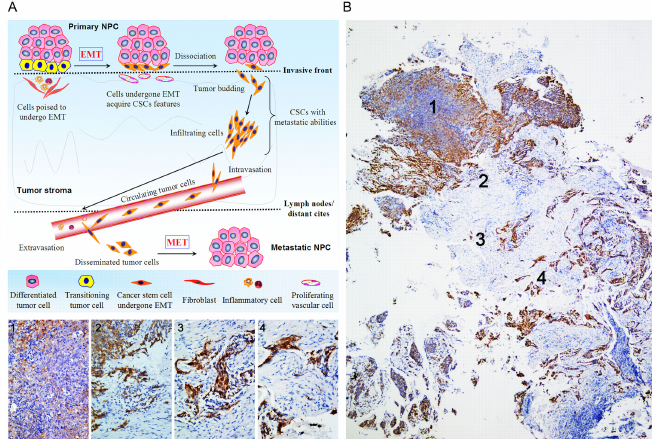
Figure 5. A molecule-morphology model of tumor progression and metastasis in NPC firstly put forward. (A) The diagram depicts that spindle cells with CSCs and EMT characteristics are crucial for NPC aggressive progression. (B) One representative case (NO.52277) with NPC provides the histological evidence for cancer pathogenesis and metastasis (Pan-cytokeratin staining). Towards central areas of primary tumors, cancer cells exhibited epithelial-like phenotypes and polarized (1). In contrast, cancer cells acquired mesenchymal-like phenotypes and lost cell polarity during tumor progression, including budding cells moving from the invasive front (2), invading the adjacent stroma (3) and the microvasculature (4). Spindle cells might be valuable morphological predictors of “mobile/migratory CSCs” and “invasive/metastatic